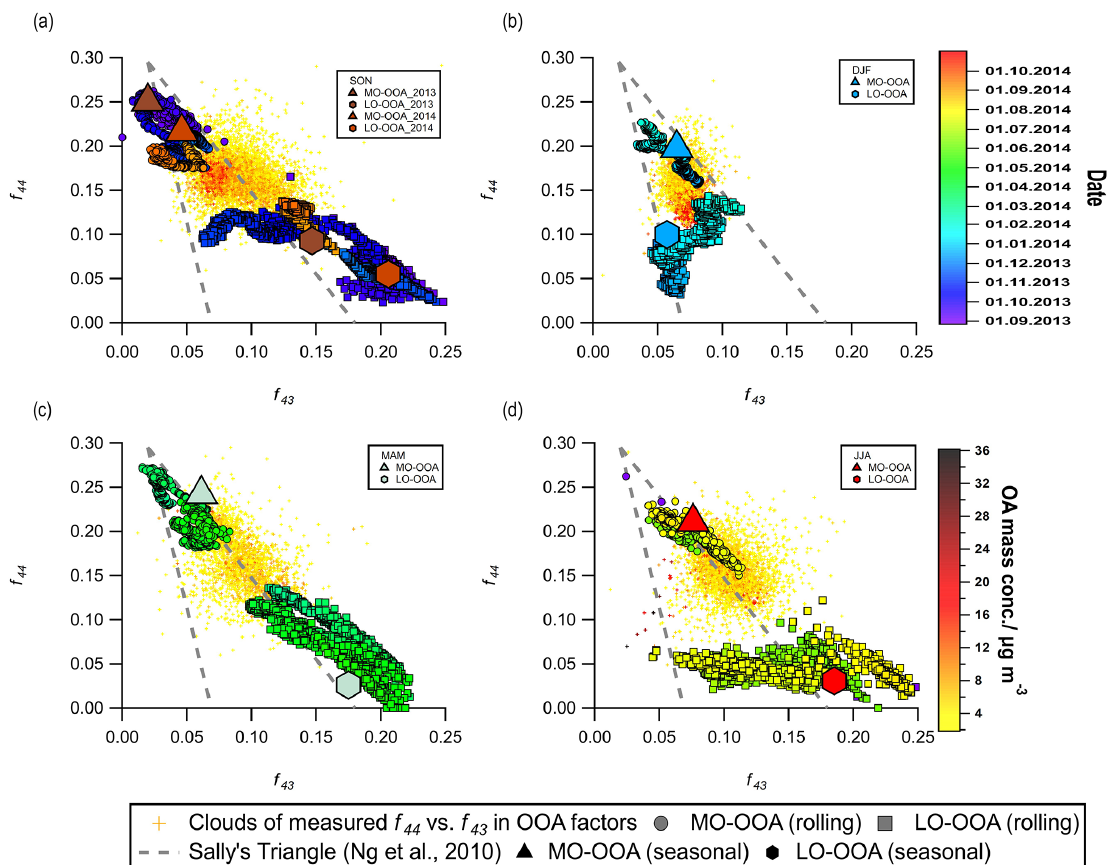
Figure 7. The f 44 and f 43 of OOA (after subtraction of signals contributed by the primary HOA, BBOA, and 58-OA factors) for four different seasons. The small yellow and red crosses of data points represent f 44 vs. f 43 . They are colour-coded by the total OA mass concentration. The bigger sizes of triangles and hexagons represent the ratios between f 44 and f 43 intensities within the factor profiles of MO-OOA and LO-OOA in seasonal solutions, respectively. The smaller sizes of circles and squares are ratios between f 44 and f 43 intensities within the factor profiles of MO-OOA and LO-OOA from rolling PMF analysis, which are colour-coded by date and time. The dashed lines represent Sally’s triangle from Ng et al. (2010) and depict the region where OOA from multiple PMF analyses during the last decade resided in the f 44 – f 43